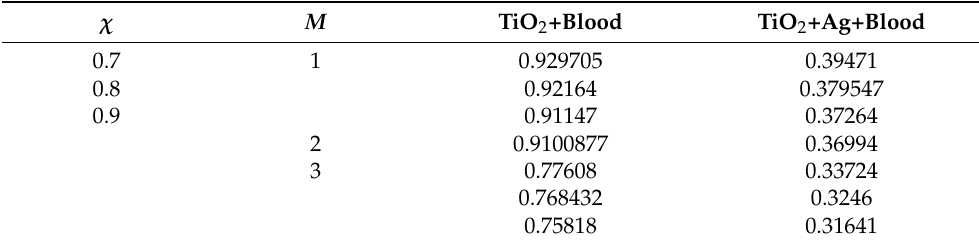
Table 1. Comparison of the skin friction for the two nanofluids when Pr = 15.6, k ∗ = 0.9, A = 0.1